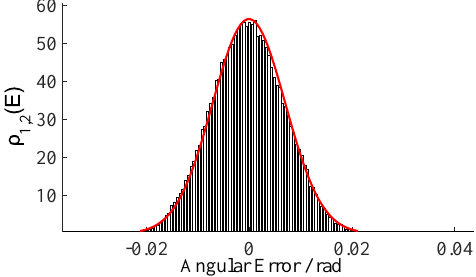
Figure 19. The propagation angular error PDF of two closed-loops.